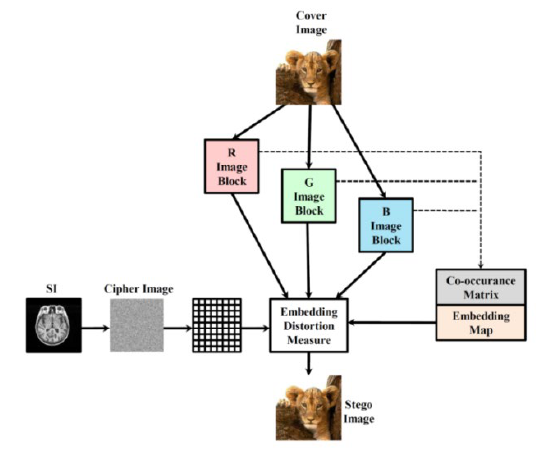
Fig. 4. Architectural diagram for embedding